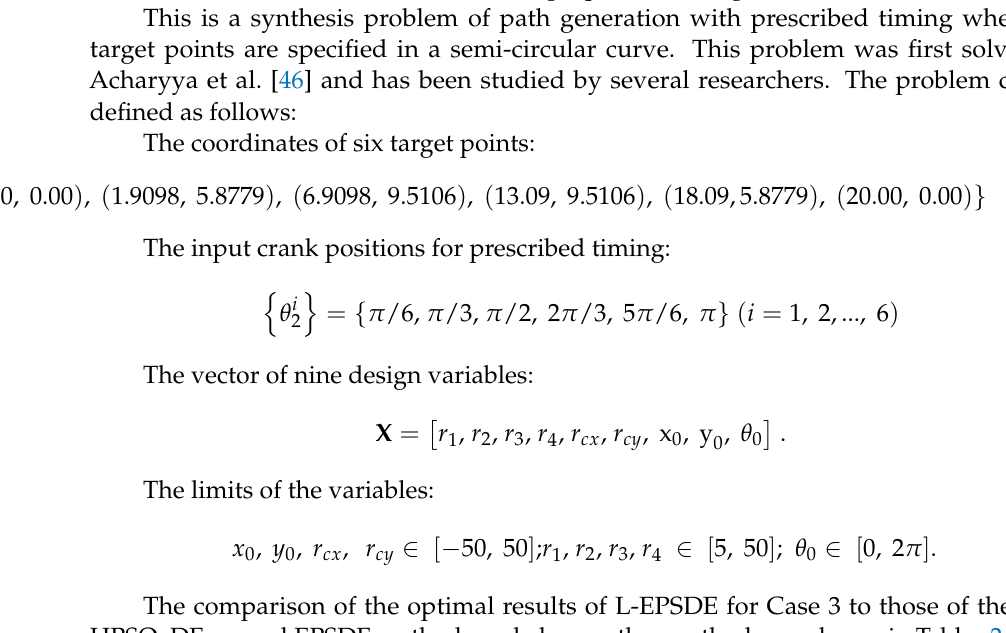
Figure 13. Convergence rate of five metaheuristic methods for Case 2. Case 3: Semi-circular arc curve (6 target points, 9 design